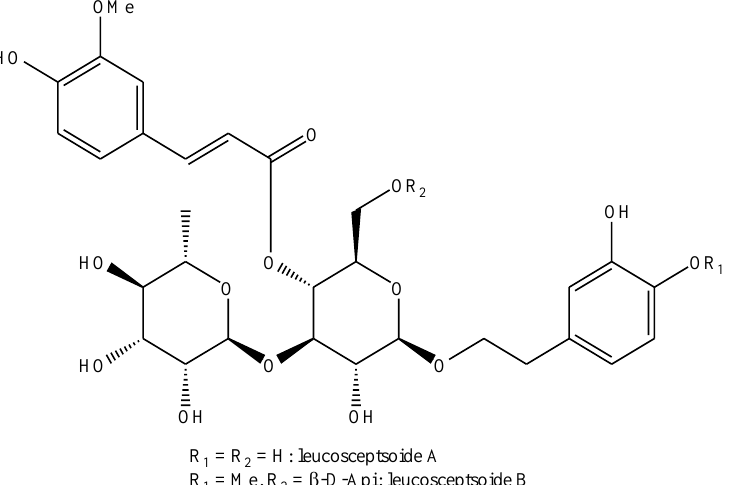
Figure 1. Structures of leucosceptoside A and leucosceptoside B.